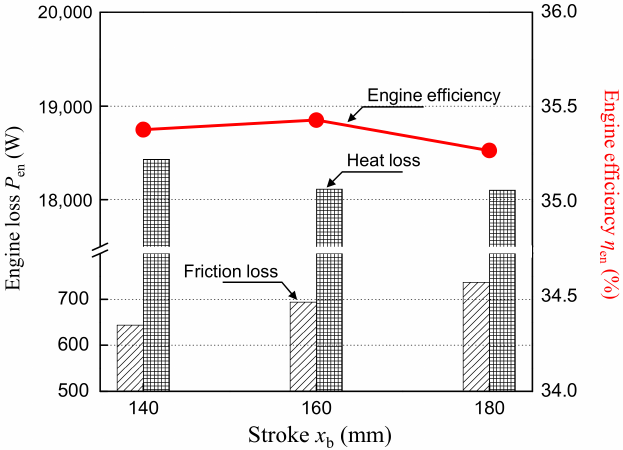
Figure 7. Relationship between the mover action stroke, heat loss, friction loss, and engine